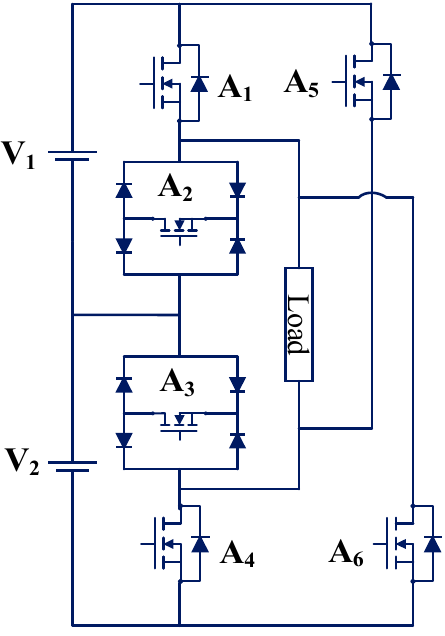
Figure 29. Single-phase five-level FT MLI (TP32) [64].